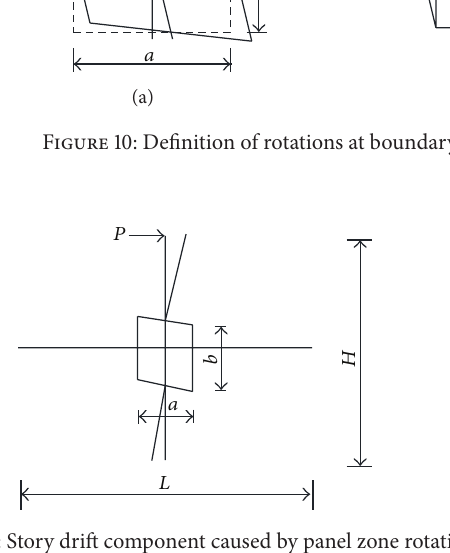
Figure 11: Story drift component caused by panel zone rotation.